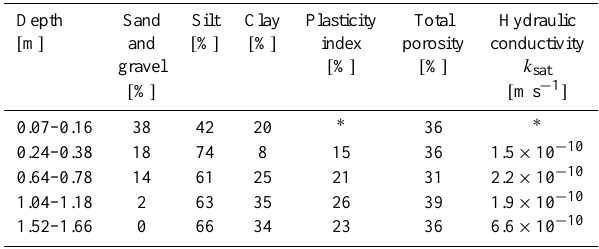
Fig. 1. Instrumentation of the Rufiberg test site. (A) 40m × 60m experimental plot with groundwater monitoring wells W1–W10 (fully filtered from 0.05 to 1.0/1.45m depth), TDR probe nests T1–T4 with sensors at 0.25, 0.7, 1.1, and 1.5m depth, and the borehole clusters B1 and B2 with three partially filtered boreholes per cluster drilled into the bedrock (Brönnimann et al., 2013). (B) 10m × 10m sprinkling plot with temporary rain gauges installed for two sprinkling experiments. (C) 1.5m × 4m brilliant blue dye application plot and the excavated frontal 1m × 1m dye profiles A1–A3, B1–B3, C1–C3 and D1–D3. For the location of the lateral dye-stained profiles please see Fig. 2.